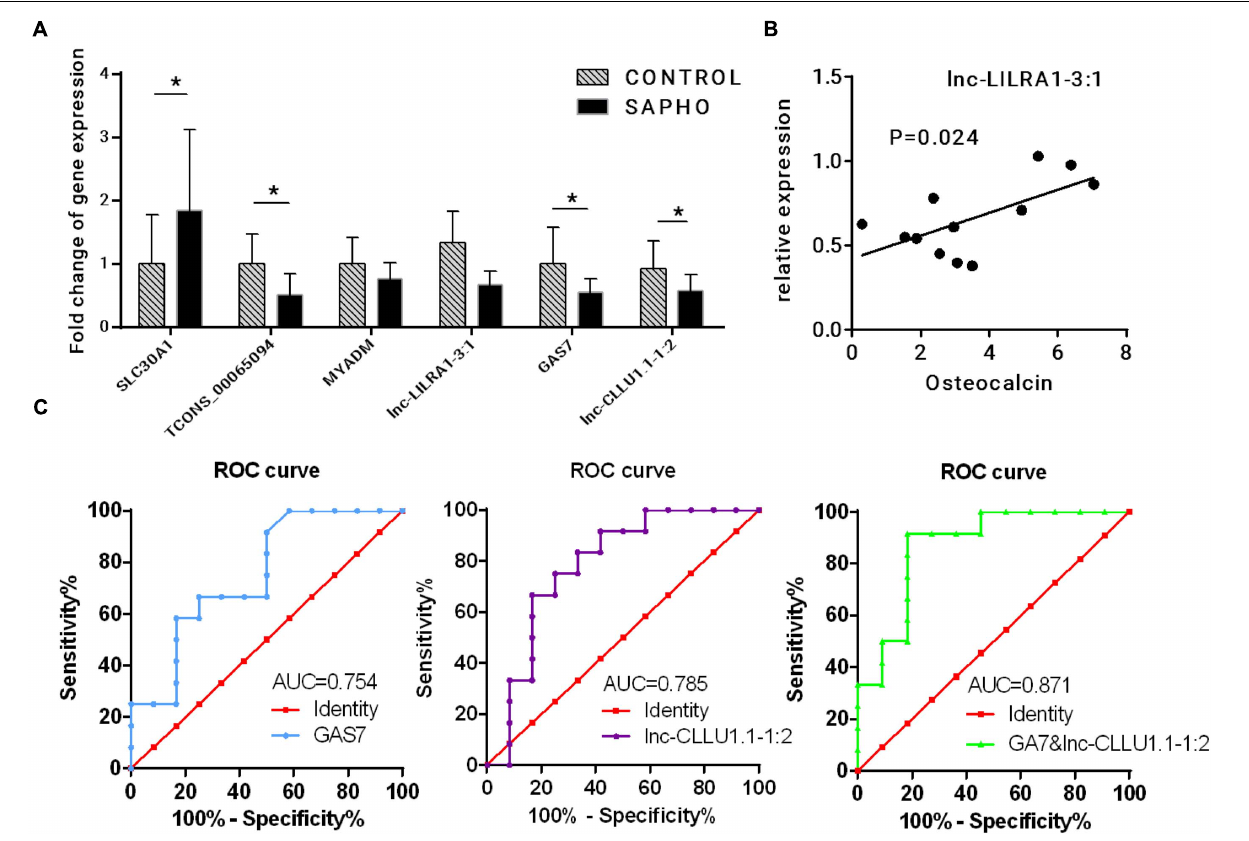
FIGURE 8 | Verification of deregulated lncRNA and mRNA. (A) Relative expression of three coexpressed lncRNA-mRNA pairs by qRT-PCR in 12 patients and 12 healthy controls. (B) The correlation between the relative expression of lnc-LILRA1-3:1 and serum osteocalcin. (C) Analysis of predictive ability of differentially expressed RNAs for